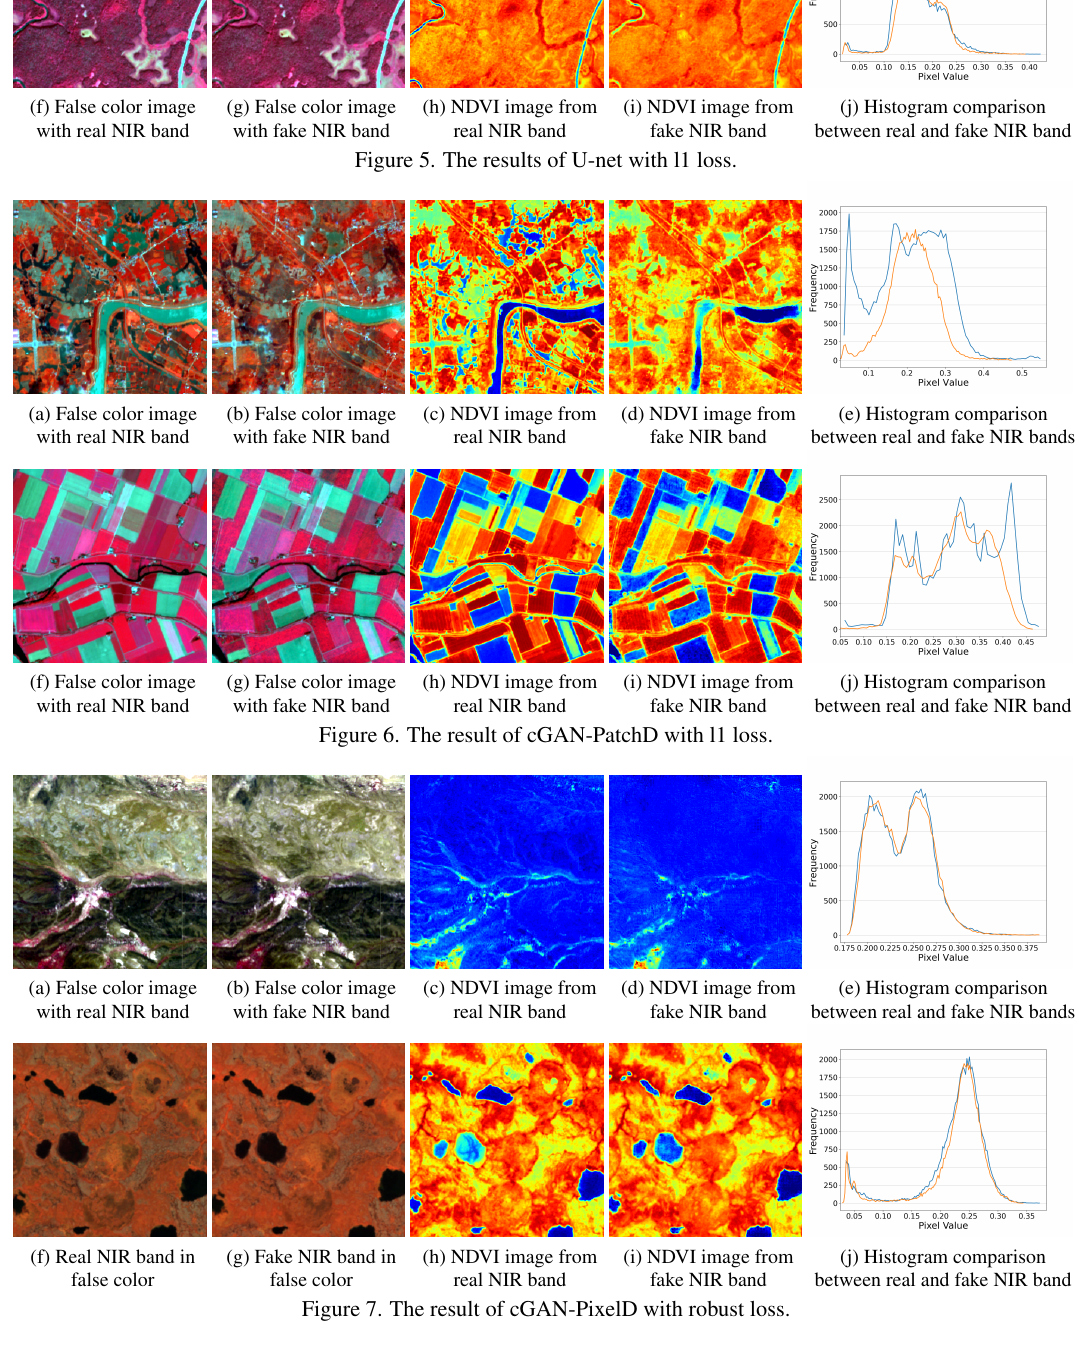
Figure 7. The result of cGAN-PixelD with robust